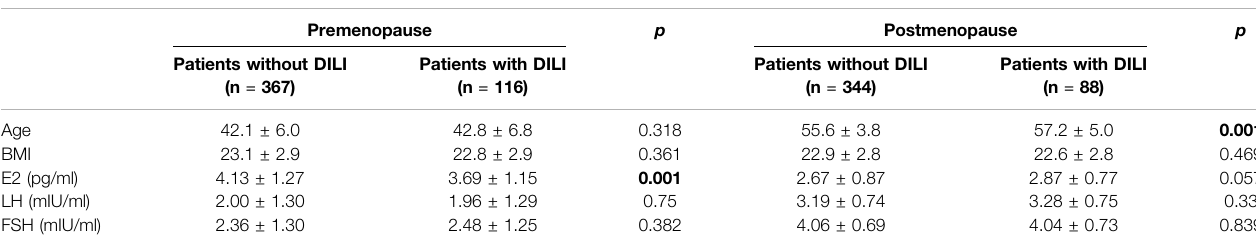
TABLE 2 | Distribution of estrogen in premenopausal and postmenopausal subgroups.